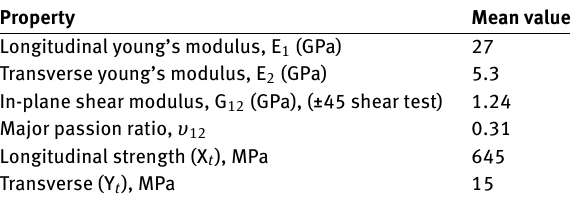
Table 1. Ply elastic properties.